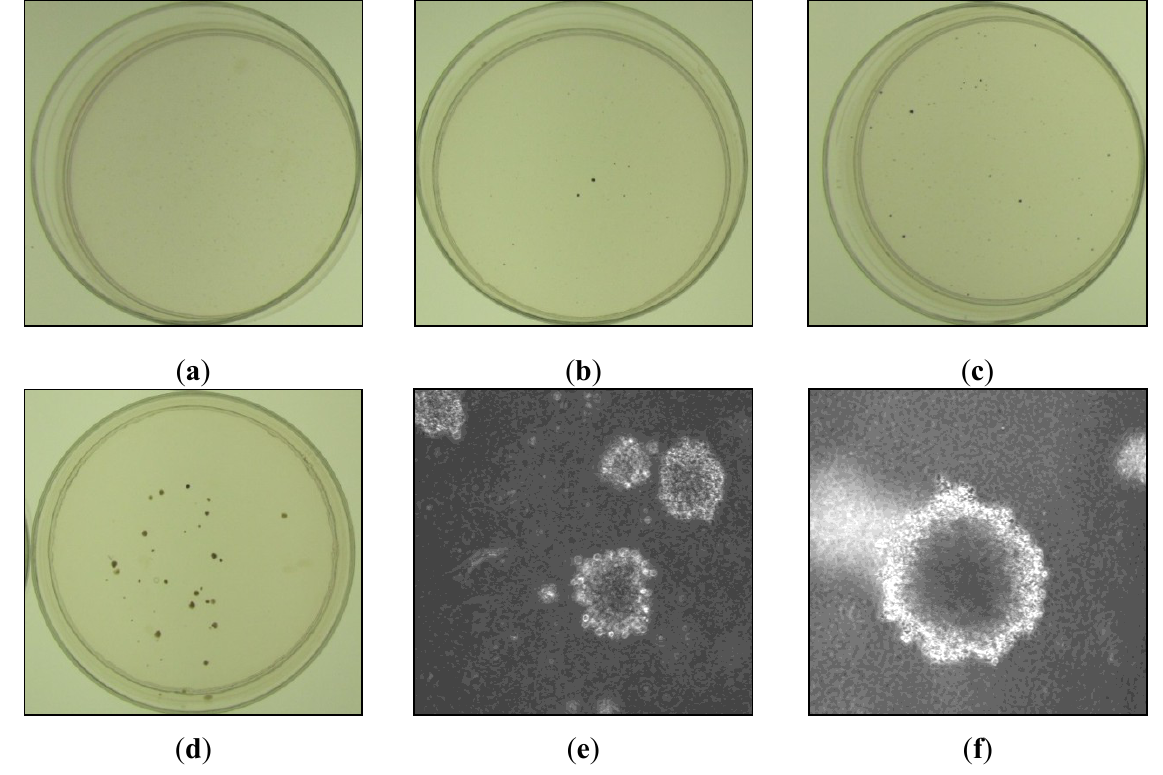
Figure 4. Representative pictures of anchorage-independent cell growth in nickel subsulfide-induced foci cells. This figure shows representative pictures of 4-nitro-blue tetrazolium chloride-stained colonies in soft agar dishes. ( a ) Control. ( b ) Foci cells isolated from 1 μg/cm 2 nickel subsulfide. ( c ) Foci cells isolated from 2.5 μg/cm 2 nickel subsulfide. ( d ) Foci cells isolated from 5 μg/cm 2 nickel subsulfide. ( e,f ) Soft agar colonies at 100× magnification.